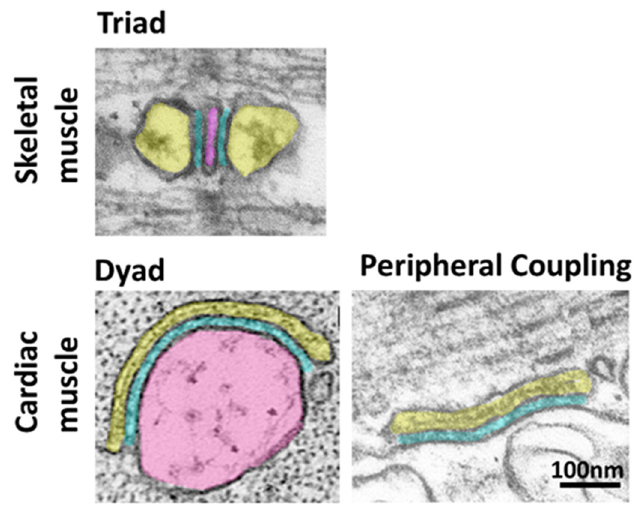
Figure 1. Organization of ER-PM junctions in skeletal and cardiac muscle. Thin section electron micrographs illustrating the different organization of ER-PM junctions in skeletal and cardiac muscle. The sarcoplasmic reticulum and the T-tubule are pseudo-colored in yellow and pink, respectively. The gap separating the T-tubule and the SR membrane is pseudo-colored in blue. The T-tubule is absent in cardiac peripheral couplings since the SR is juxtaposed to the plasma membrane at the periphery of the fiber. Images are from Perni et al. [4] (triad), Lavorato et al. [5] (dyad) and Perni et al. [6] (peripheral coupling).